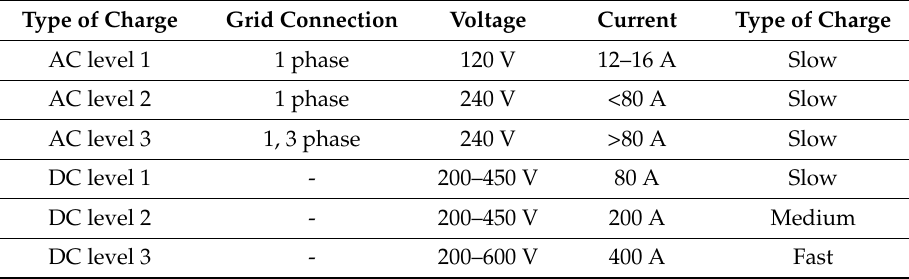
Table 2. Standard charging power levels in the SAE J1772 standard [17].